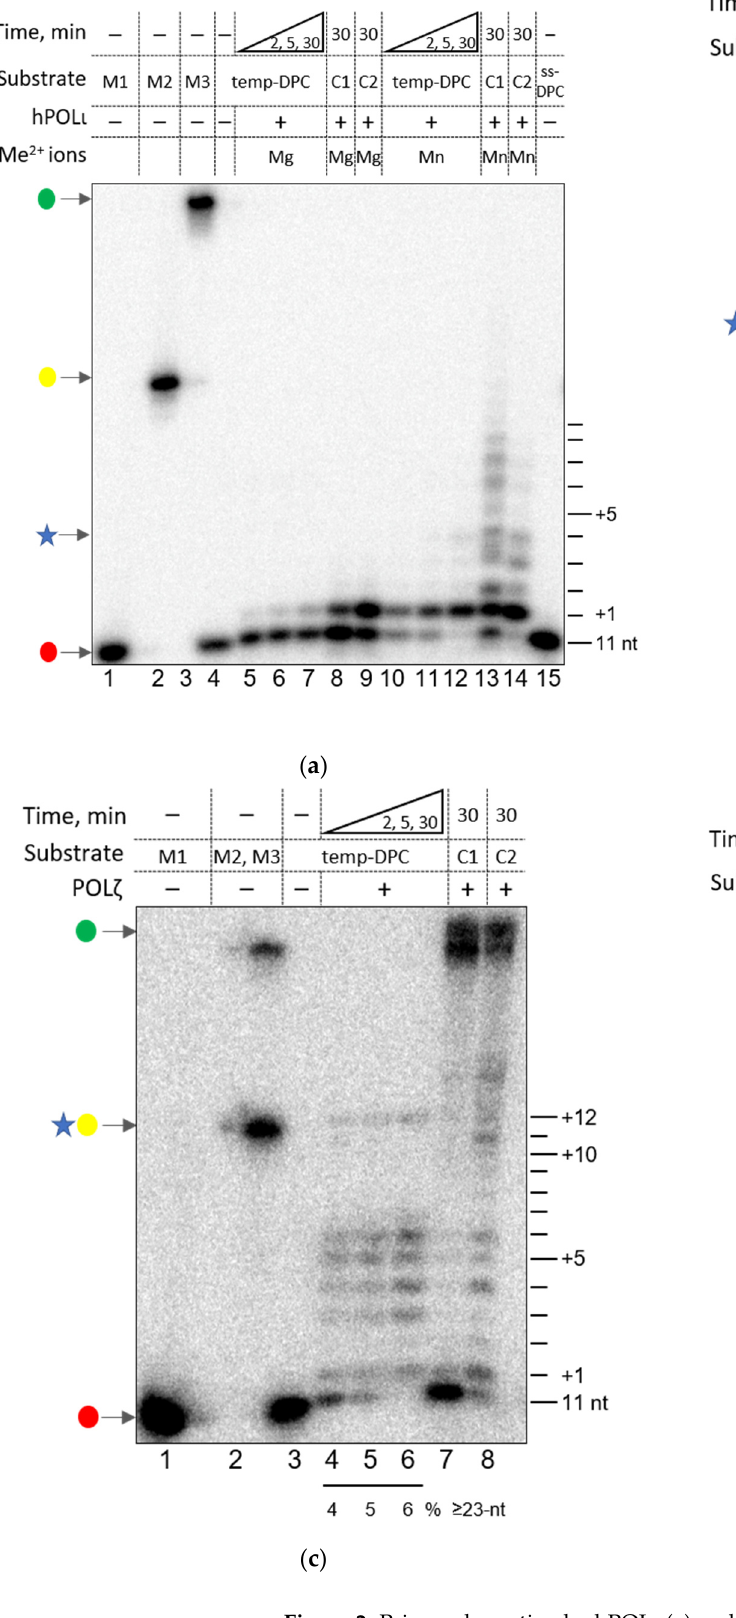
Figure 2. Primer elongation by hPOL ι ( a ) and yPOL ζ ( b – d ) encountering a DNA protein cross-link. For yPOL ζ , panel ( b ) shows the ss-DPC substrate, panel ( c ) shows the temp-DPC substrate, and panel ( d ) shows the down-DPC substrate. The red dots mark the primers, the yellow dots corre- spond to the synthesis until the cross-link site, and the green dots indicate the full-sized products.